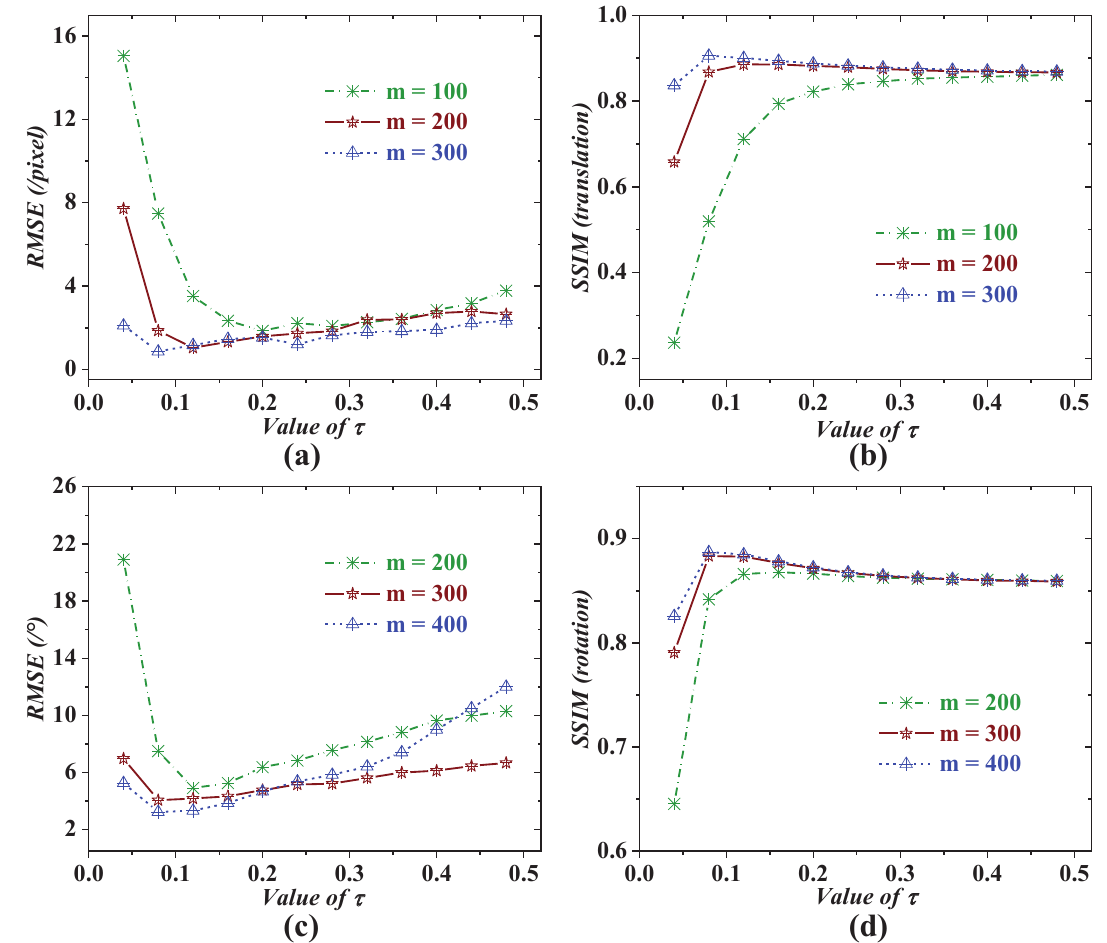
Figure 6. The influence of the penalty parameter τ on ( a ) the object translation estimation accuracy evaluated by the RMSE; ( b ) the reconstructed image quality of the translating object evaluated by the SSIM; ( c ) the object rotation estimation accuracy; ( d ) the image quality of the rotating object, under different measurement number m per image